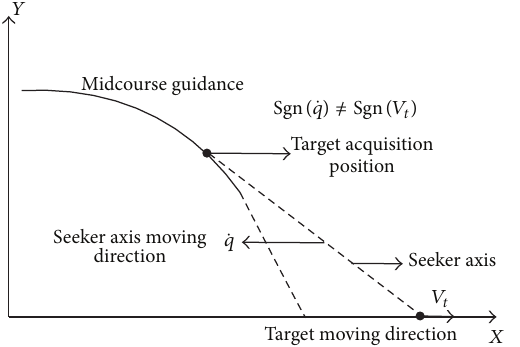
Figure 7: Midcourse guidance law without LOS angle rate control.